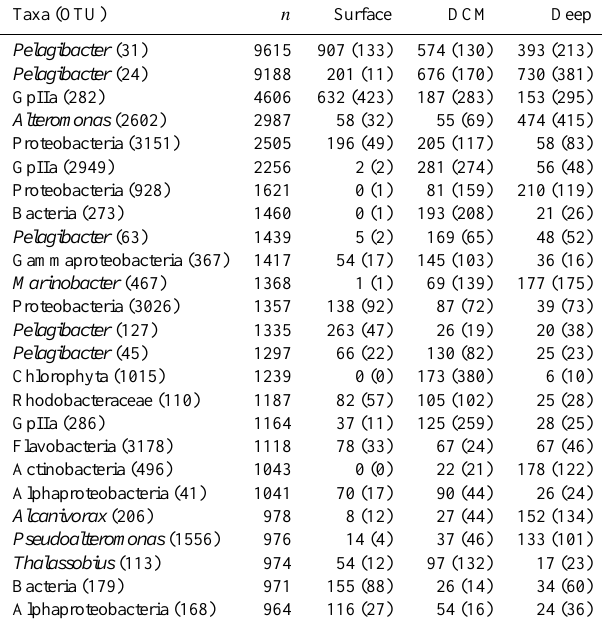
Table 2. Taxonomic affiliation of the 25 most abundant operational taxonomic units (OTUs) across all 16 Atlantic Ocean bacterial com- munities sampled. The table shows the total normalized OTU abun- dance ( n ) as well as the mean and standard deviation according to habitat. The number of samples in each zone are 4, 7, and 5 for surface, DCM, and deep, respectively. The numerical identifier of each OTU is shown in parentheses in the first column to differenti- ate OTUs with identical taxonomic labels.